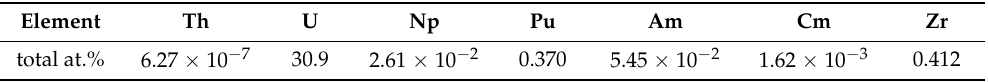
Table 3. Total atom percentages for actinides and Zr calculated for the test fuel rod irradiated at Gösgen PWR after an average burn-up of 50.4 GWd/tHM (summed over all relevant isotopes per element). Element Th U Np Pu Am Cm Zr total